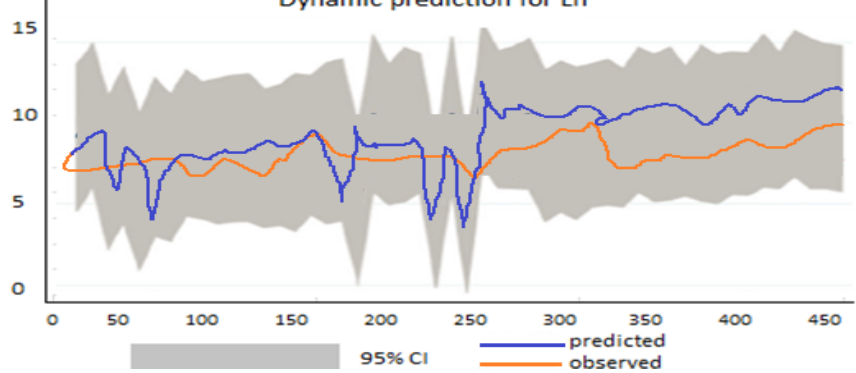
Figure 3. Dynamic prediction of the response variable.